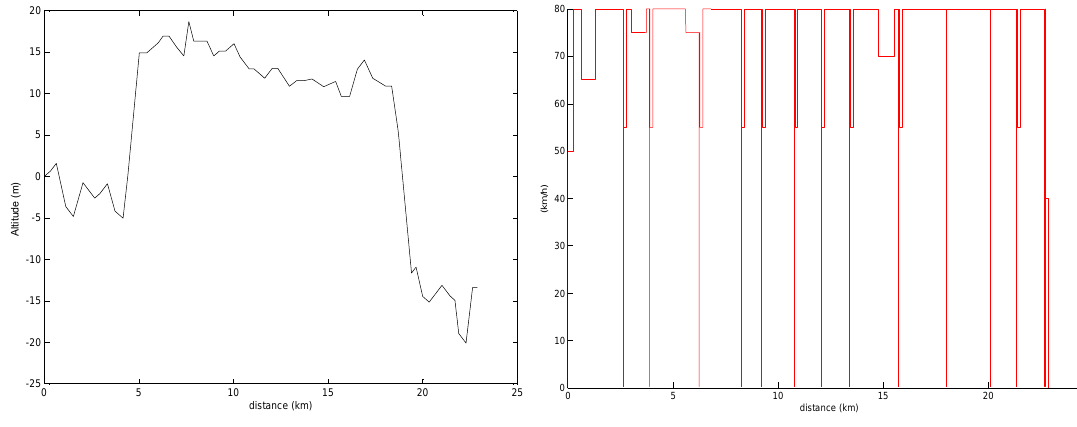
Figure 4. Gradient and speed limits of the Beijing Yizhuang line.